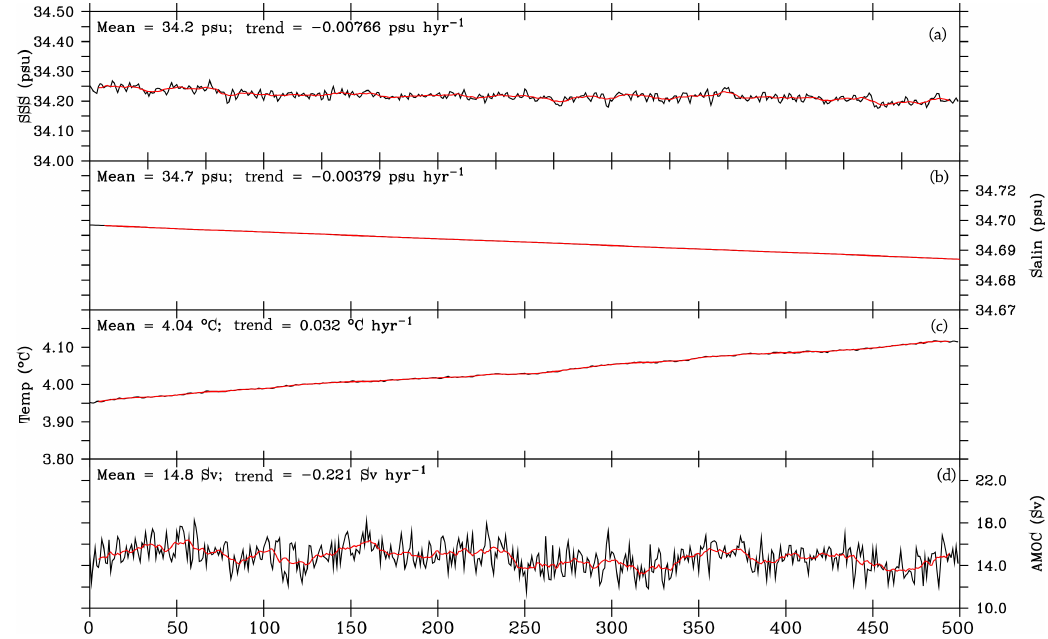
Figure 4. Results from the preindustrial control experiment. Annual mean time series of the ocean variables from year 0 to 500; from top: sea surface salinity (psu), sea water salinity (psu), sea water temperature ( ◦ C), and AMOC strength at 26.5 ◦ N (sv). The sea water salinity and sea water temperature are the volume mean values for the full-depth global ocean. The long-term mean value and trend are indicated in the upper left corner. The black lines are annual mean values and the red lines are their 9-year running mean values.